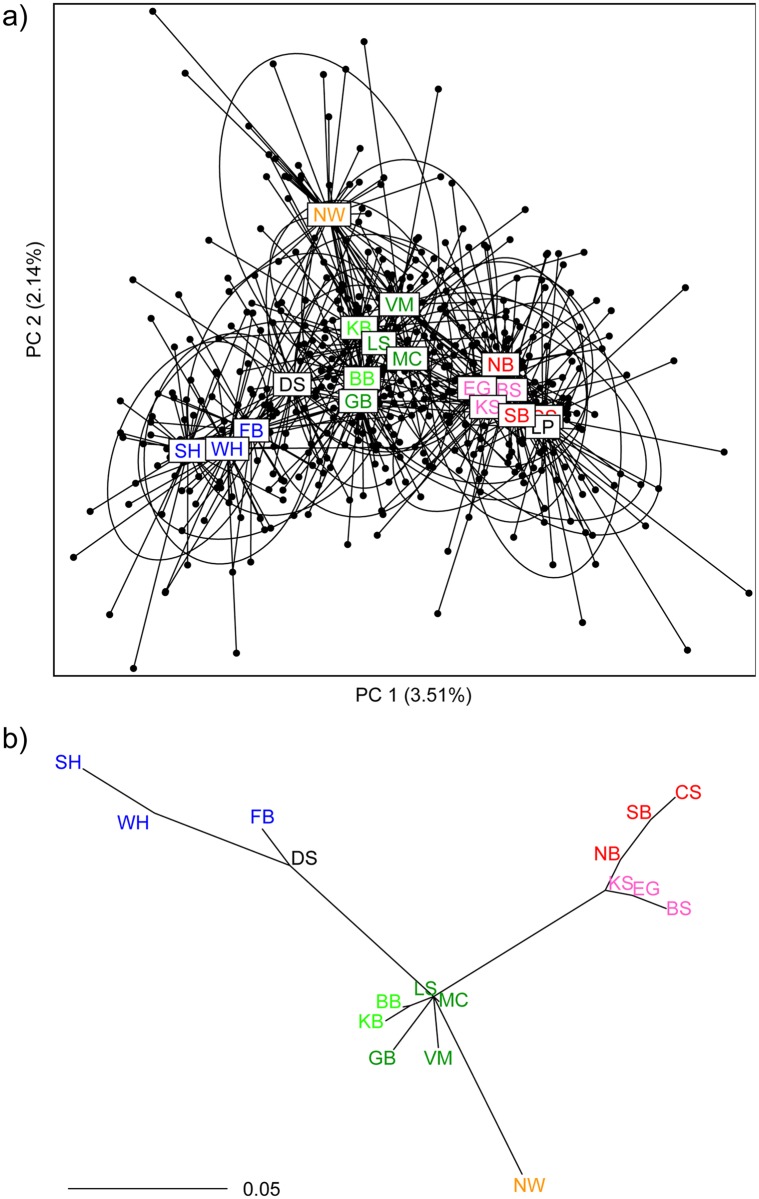
(a) Principal component analysis of genetic variation. Each point represents an individual; each individual is connected to a label indicating the centroid of the management unit in which it was sampled. The inertia ellipse for each management unit contains approximately two-thirds of all individuals sampled there. (b) Population tree. The scale bar indicates Nei’s standard distance; branch lengths were estimated using non-negative least squares, and the tree has an R2 [79] of 0.903. Samples from the Laptev Sea (LP) have been excluded in (b) because a large spatial discontinuity in sampling in this management unit resulted in it being significantly out of Hardy–Weinberg equilibrium. Management unit abbreviations are as in Table 1 and are coloured as in Fig 4.